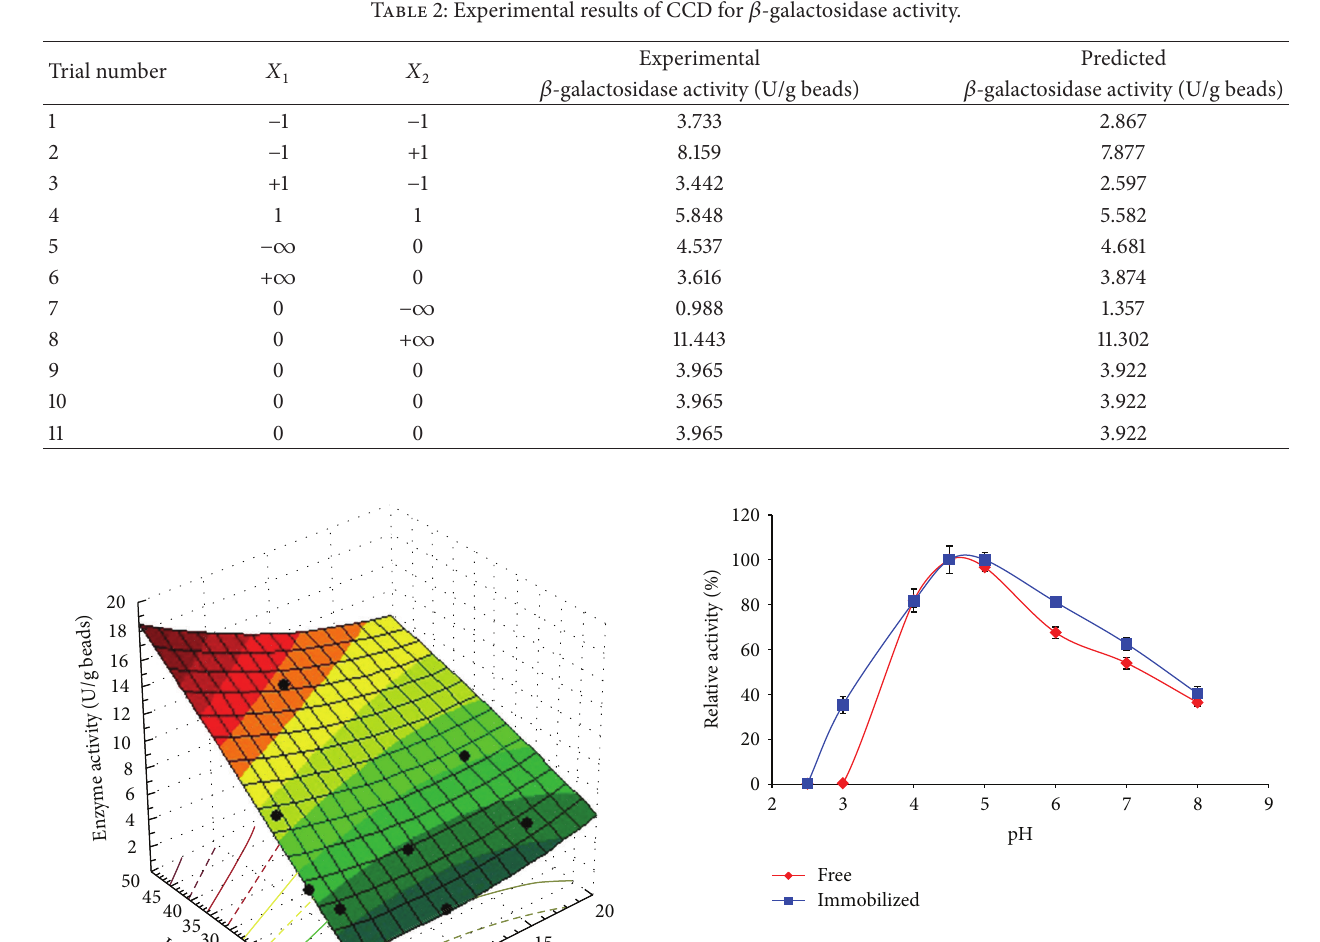
Figure 3: Optimum pH for free and covalently immobilized 𝛽 - galactosidase onto gel beads treated with polyethylenimine (PEI), followed by glutaraldehyde using free